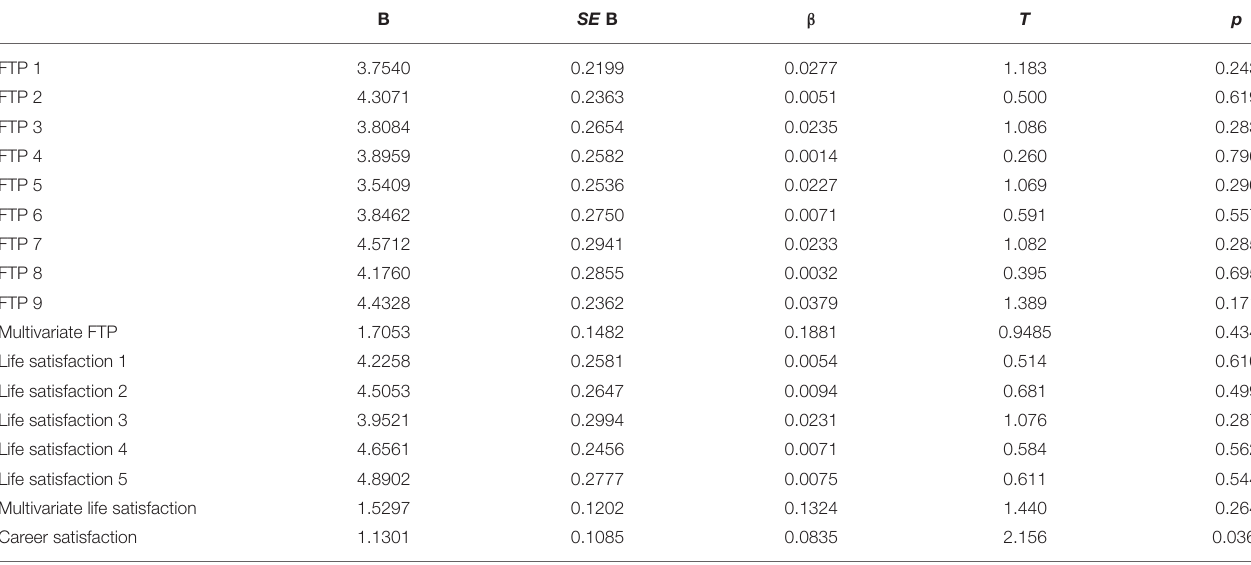
TABLE 8 | Logistic regression between the question “to what extent has your employment or retirement status been affected by the coronavirus pandemic” and measures of future time perspective (FTP), life satisfaction, and career satisfaction. B SE B β T p FTP